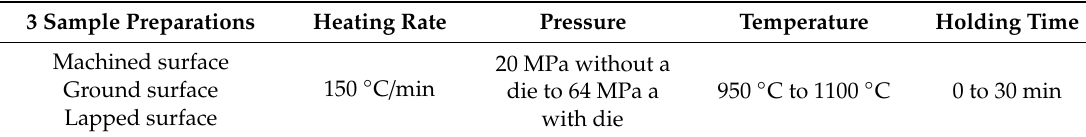
Table 1. Experimental conditions for SPS joining of ODS steel